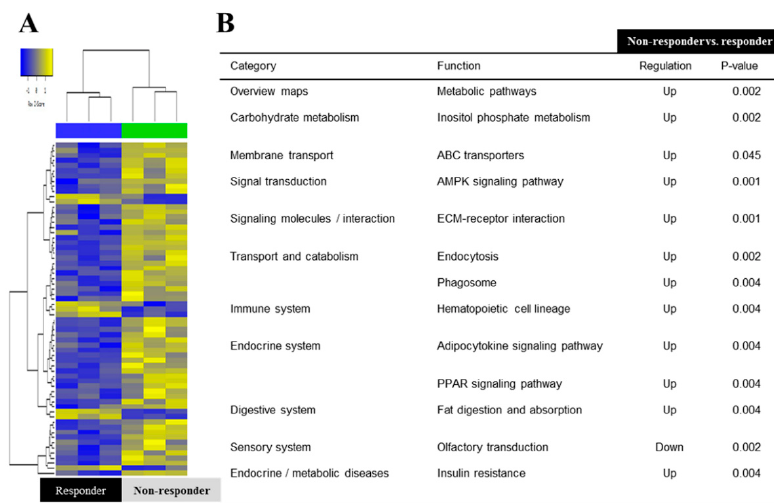
Figure 3. Microarray analysis between non-responders and responders. ( A ) Heat map depicting the expression of di ff erentially expressed genes encoding various markers in BM-MSCs. ( B ) The KEGG Pathway mapped for significantly dysregulated pathways in non-responders and responders. ABC, ATP-binding cassette transporters; AMKP, AMP-activated protein kinase; ECM, extracellular matrix; PPAR, peroxisome proliferator-activated